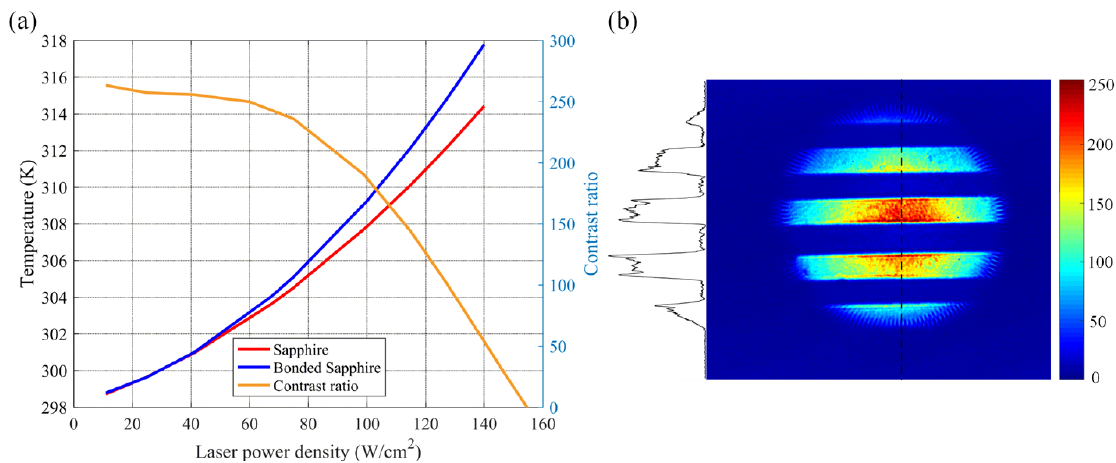
Figure 9. ( a ) Temperature of sapphire on both sides of the OASLM device as a function of laser power density and the changes in contrast ratio with power intensity. ( b ) Light field distribution of bilateral sapphire OASLM output at 100 W/cm 2 .